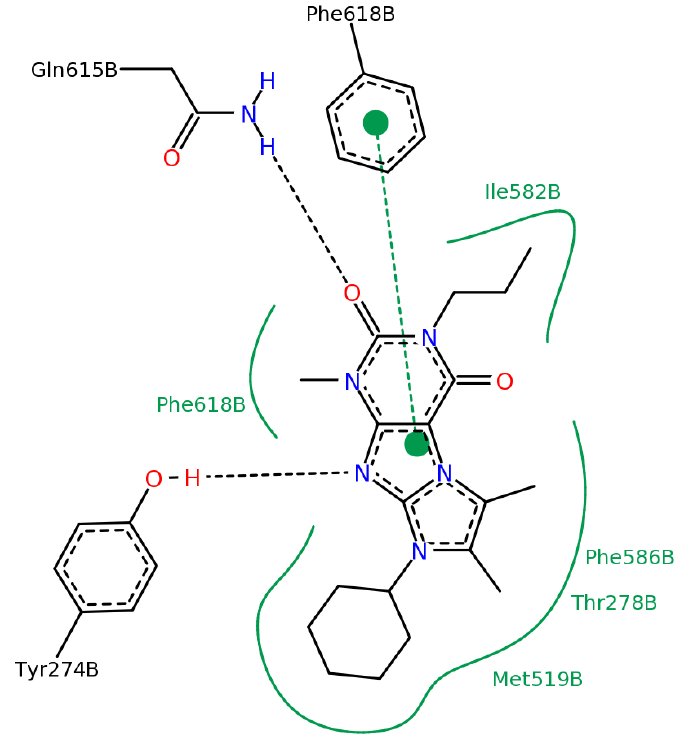
Figure 13. Diagram of the most important interactions in the Glide XP calculated PDE4B—#2 (2nd round hit) complex identified by PoseView. Black dashed lines represent hydrogen bonds, green solid lines represent hydrophobic interactions and green dashed lines represent aromatic